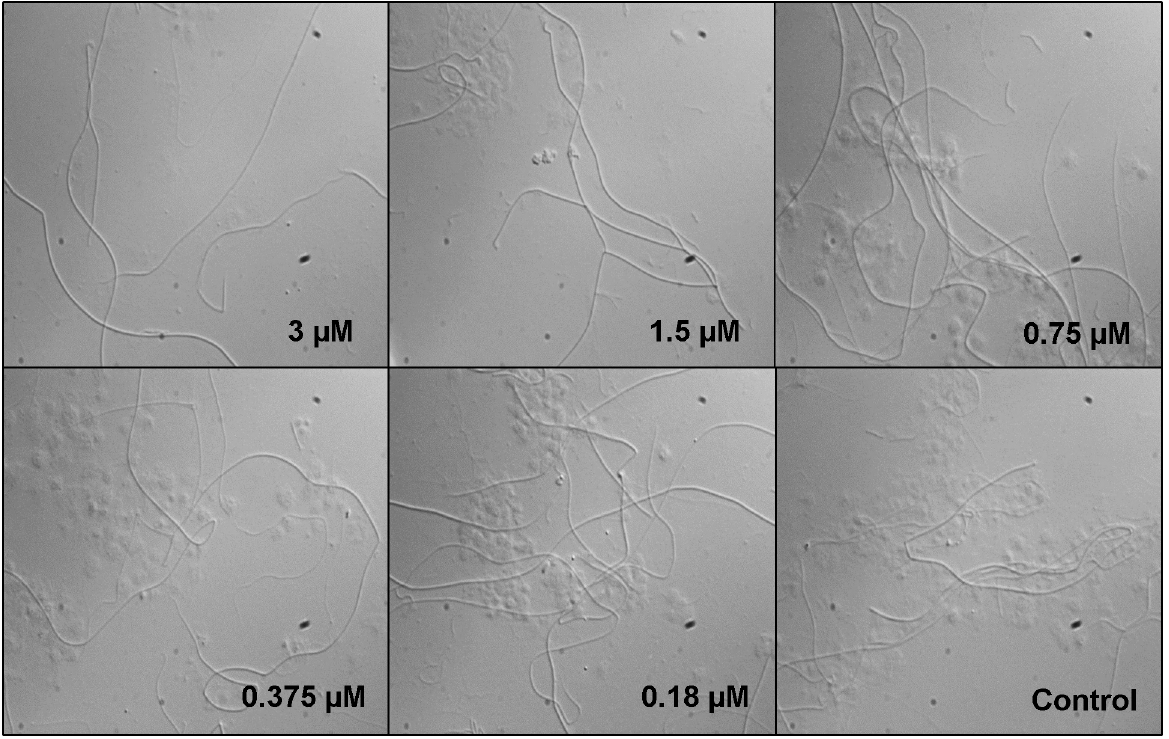
Figure 10. Effect of Simplagrin on platelet adhesion to fibrillar collagen under high shear stress. Simplagrin inhibits platelet collagen interaction under high shear stress in a dose dependent fashion. Anticoagulated whole blood from healthy patients was perfused over immobilized fibrillar collagen for 240 seconds at a shear rate of 1500 s 2 1 in the presence of different doses of Simplagrin and immediately perfused with Tyrode’s buffer at the same shear rate to remove loosely bound platelets. Coverslips were mounted and analyzed under bright-field microscopy. Representative results of a typical experiment (n=6).